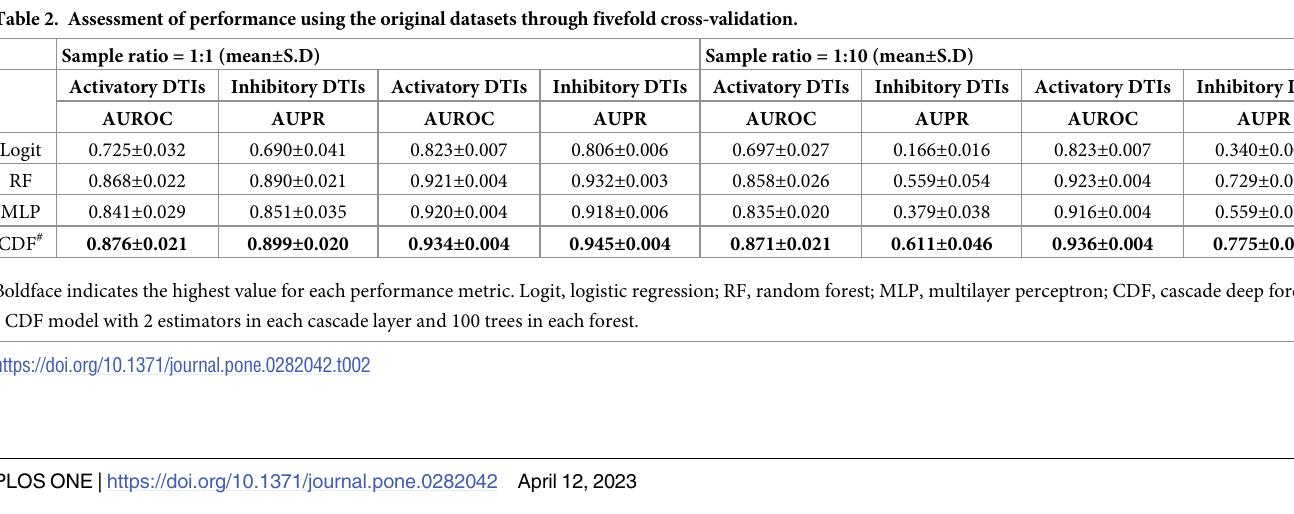
Table 2. Assessment of performance using the original datasets through fivefold cross-validation. Sample ratio = 1:1 (mean ± S.D) Sample ratio = 1:10 (mean ± S.D)